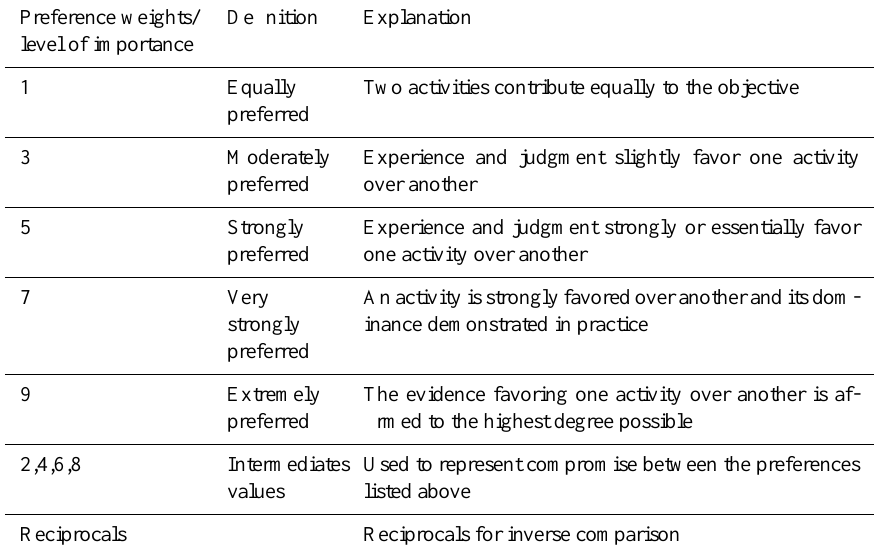
Table 1. Scale of preference between two elements (Saaty, 1998, 2001; Hafeez et al., 2002).